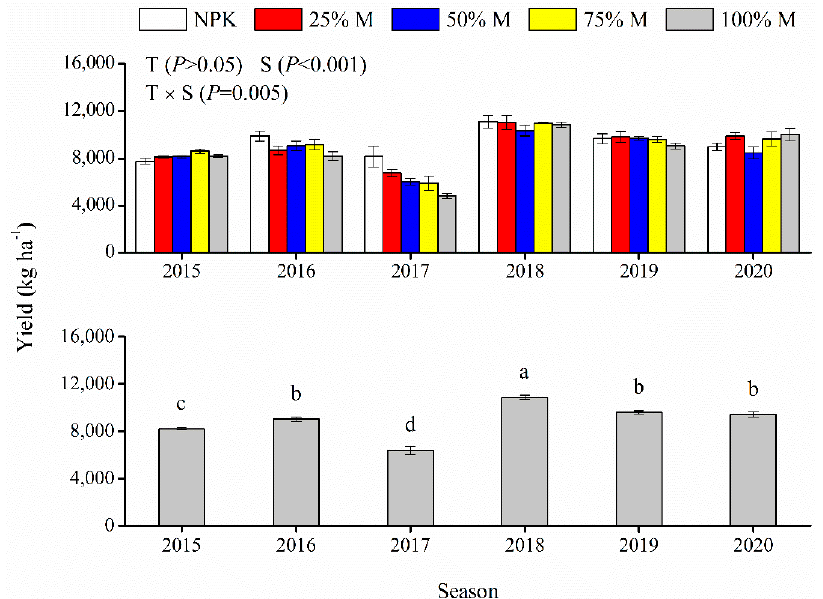
Figure 3. Maize grain yield under different treatments of winter wheat–summer maize cropping system during 2014–2020. Bars represent standard error. Different letters above bars are significantly different between treatments or years at P < 0.05.